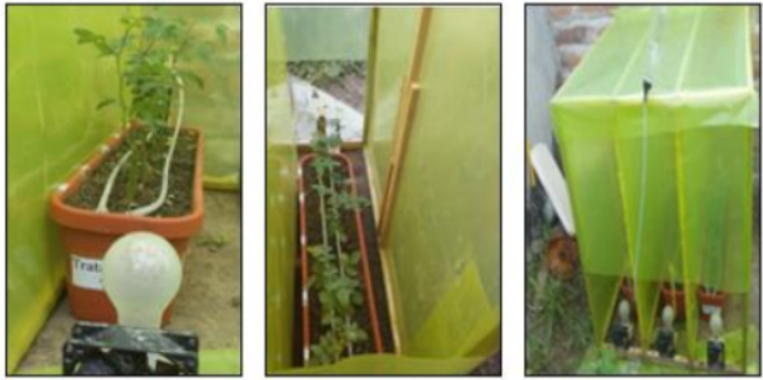
Figure 6. Rose crop